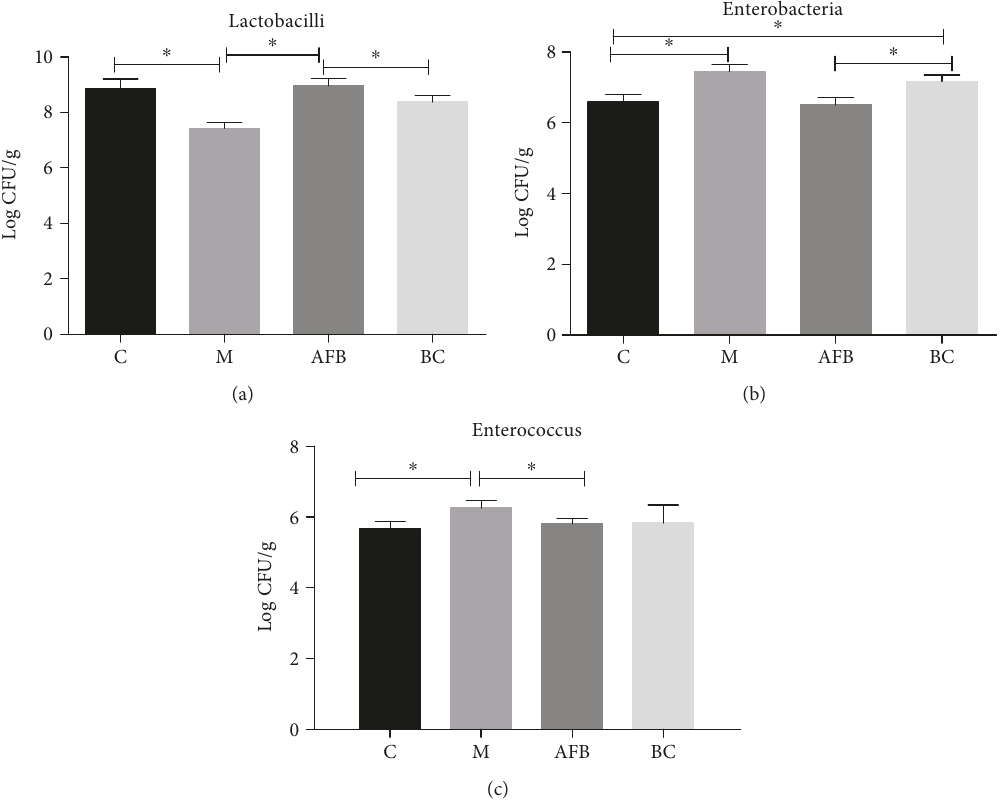
Figure 5: The fecal microbial number of genus Lactobacillus , Enterobacteriaceae , and Enterococcus among the C, M, AFB, and BC groups using the viable cell count method. C, control group; M, model group; AFB: aloe-fermented liquid group; BC: burn cream group. Data are shown as the mean ± SD. ∗ p < 0 05